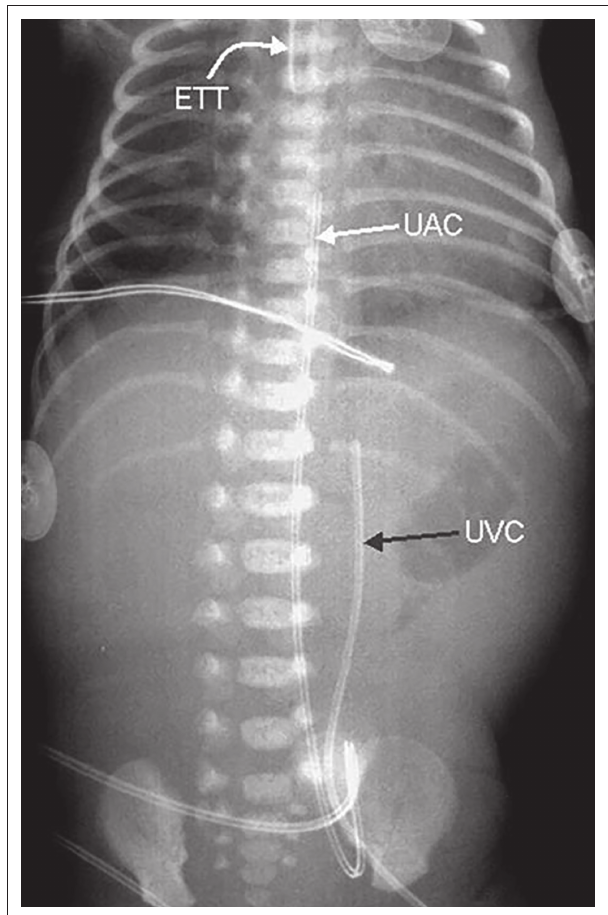
the umbilical venous catheter (UVC) in this X-ray. Is there an anomaly? No, this finding is due to poor technique, as the patient is rotated to the left. On a correctly positioned AP view, the UVC should lie to the right of the UAC, in keeping with the normal aorta–IVC